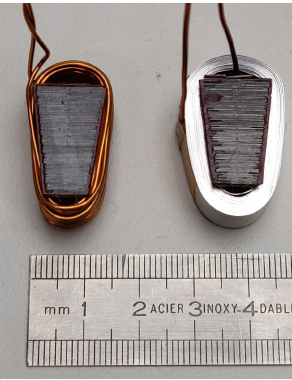
Figure 7. Prototype tooth coils. Left: enamelled copper wire tooth coil, Right: anodised aluminium foil tooth